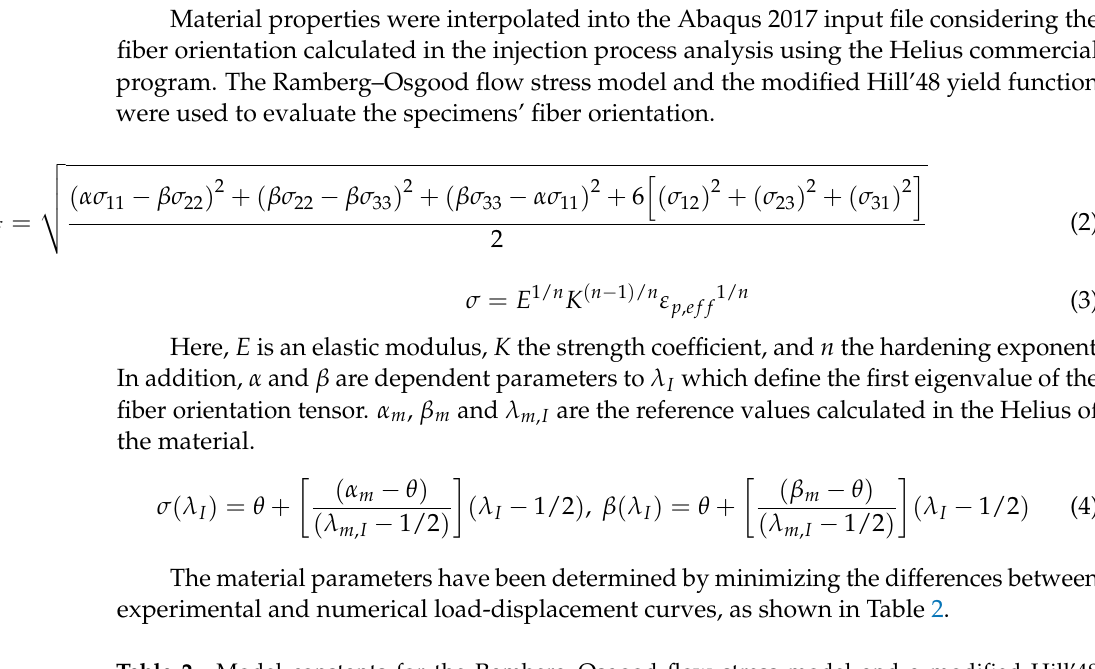
Table 1. Process parameter setting values in the injection analysis for the plate and cross-member. Process Parameters Plate Cross-Member Mold surface temperature [ ◦ C] 85 Melt temperature [ ◦ C] 285 99 Injection time [s] 20